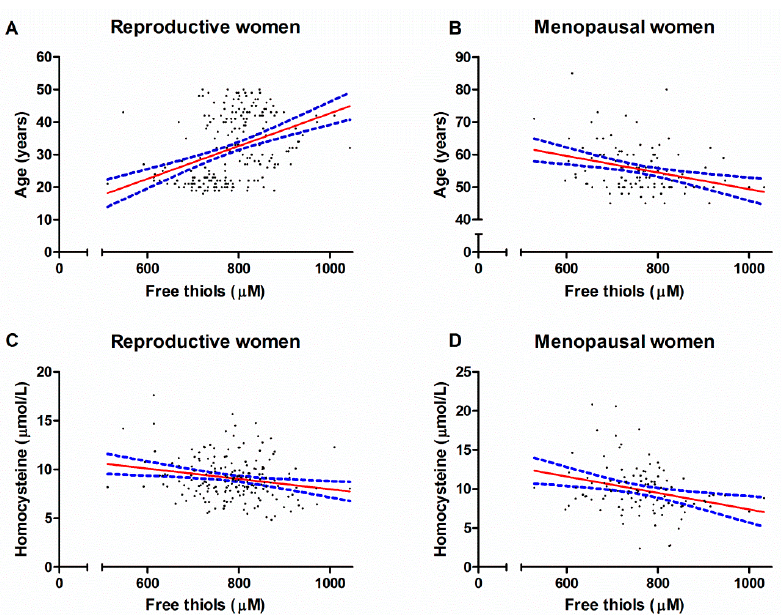
Figure 1. Univariable associations between serum free thiol concentrations and age ( A , B ) and serum free thiol concentrations and homocysteine levels ( C , D ) among reproductive women and menopausal women.